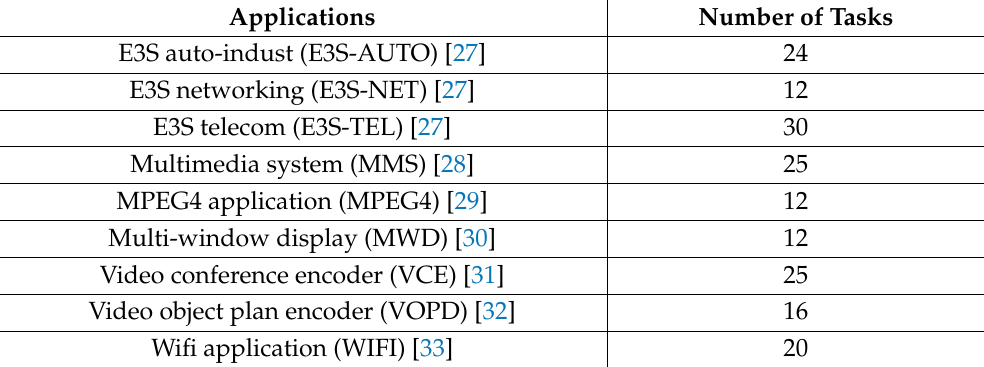
Table 3. Realistic application